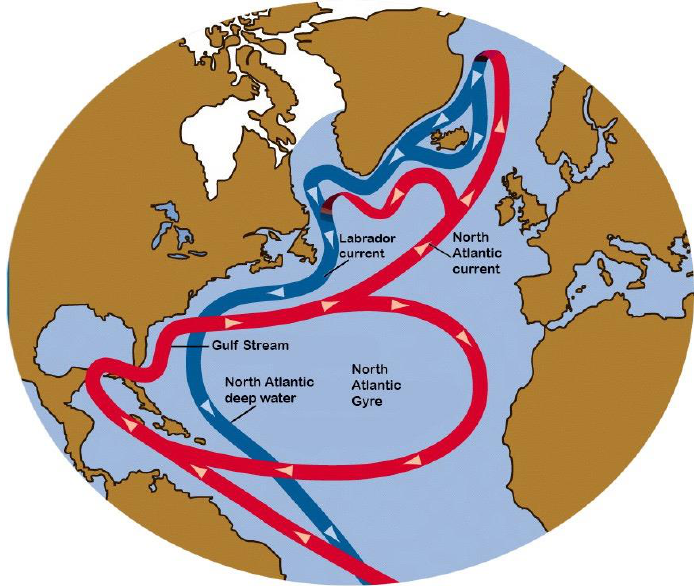
Figure 5. Circulation of the North Atlantic Gulf Stream (source, [72]).